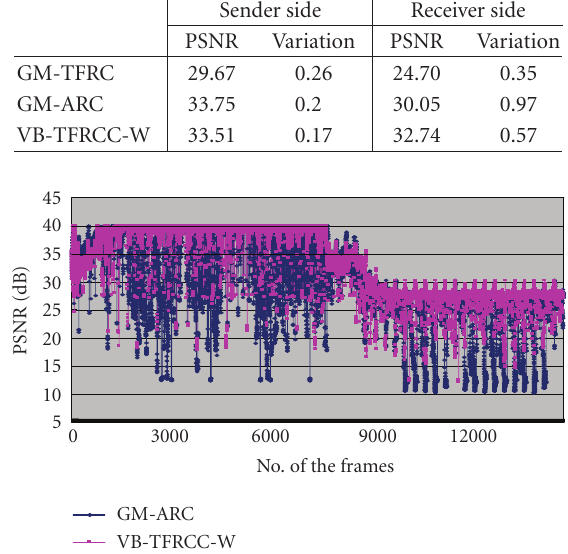
Figure 9: The PSNR curve of the sequences decoded by the decoder of one GM-ARC flow and one VB-TFRCC-W